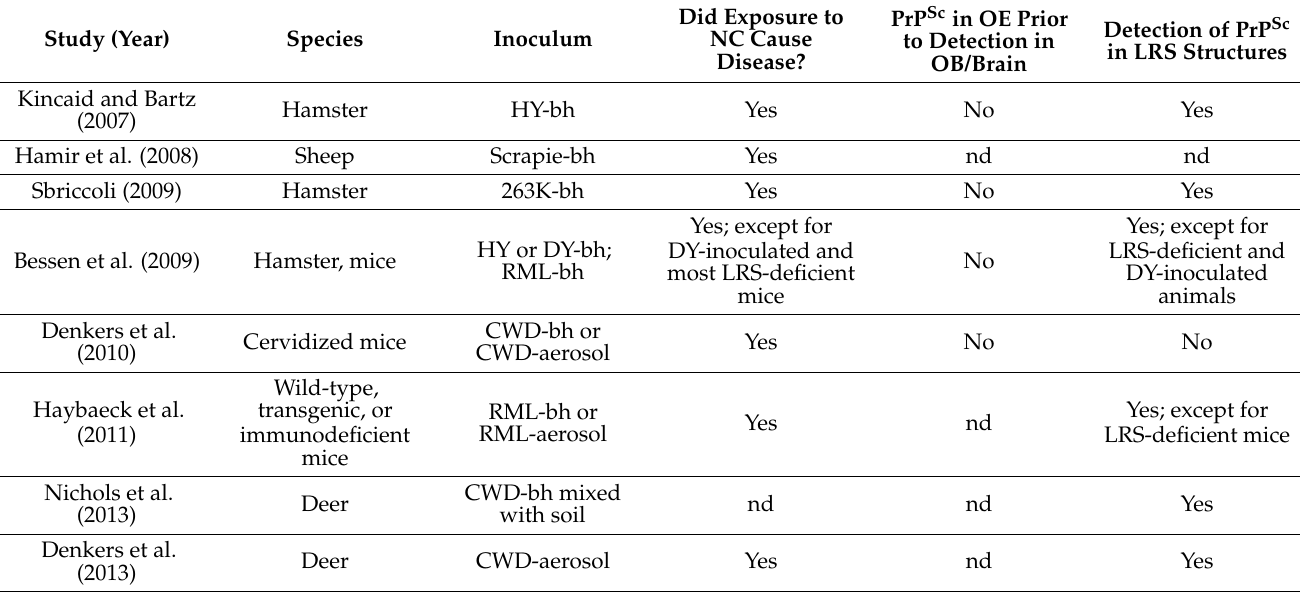
Table 1. Experimental evidence for centripetal spread of prions via the nasal cavity.